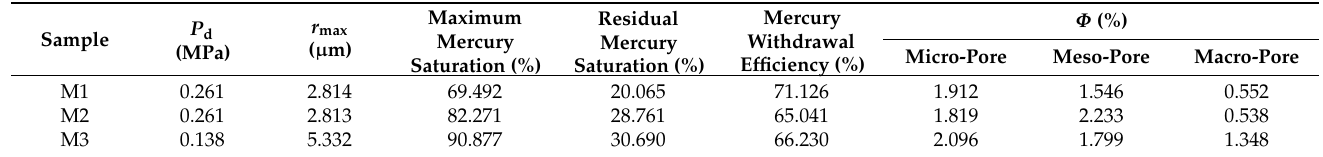
Table 1. Results of MIP experiment.